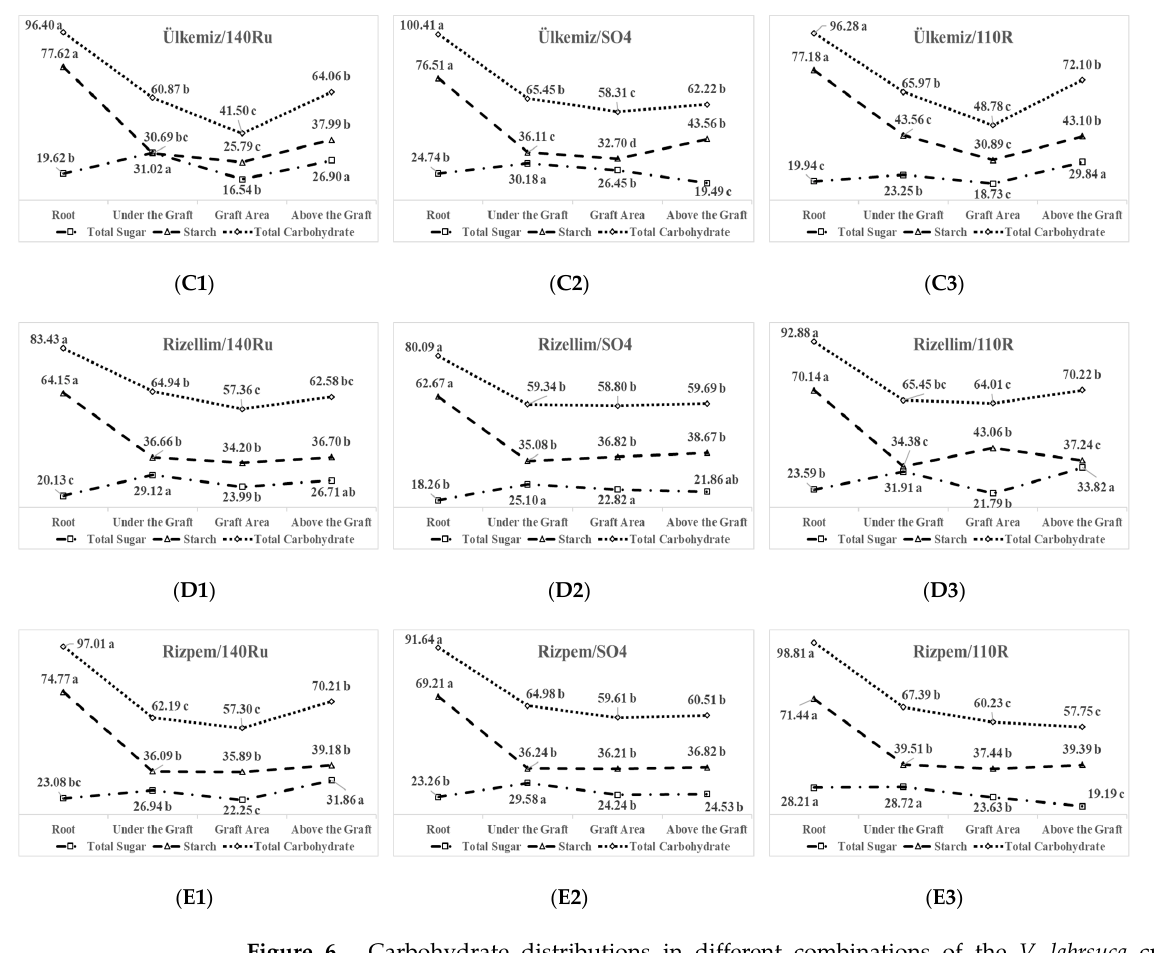
Figure 6. Carbohydrate distributions in different combinations of the V. labrsuca cultivars.